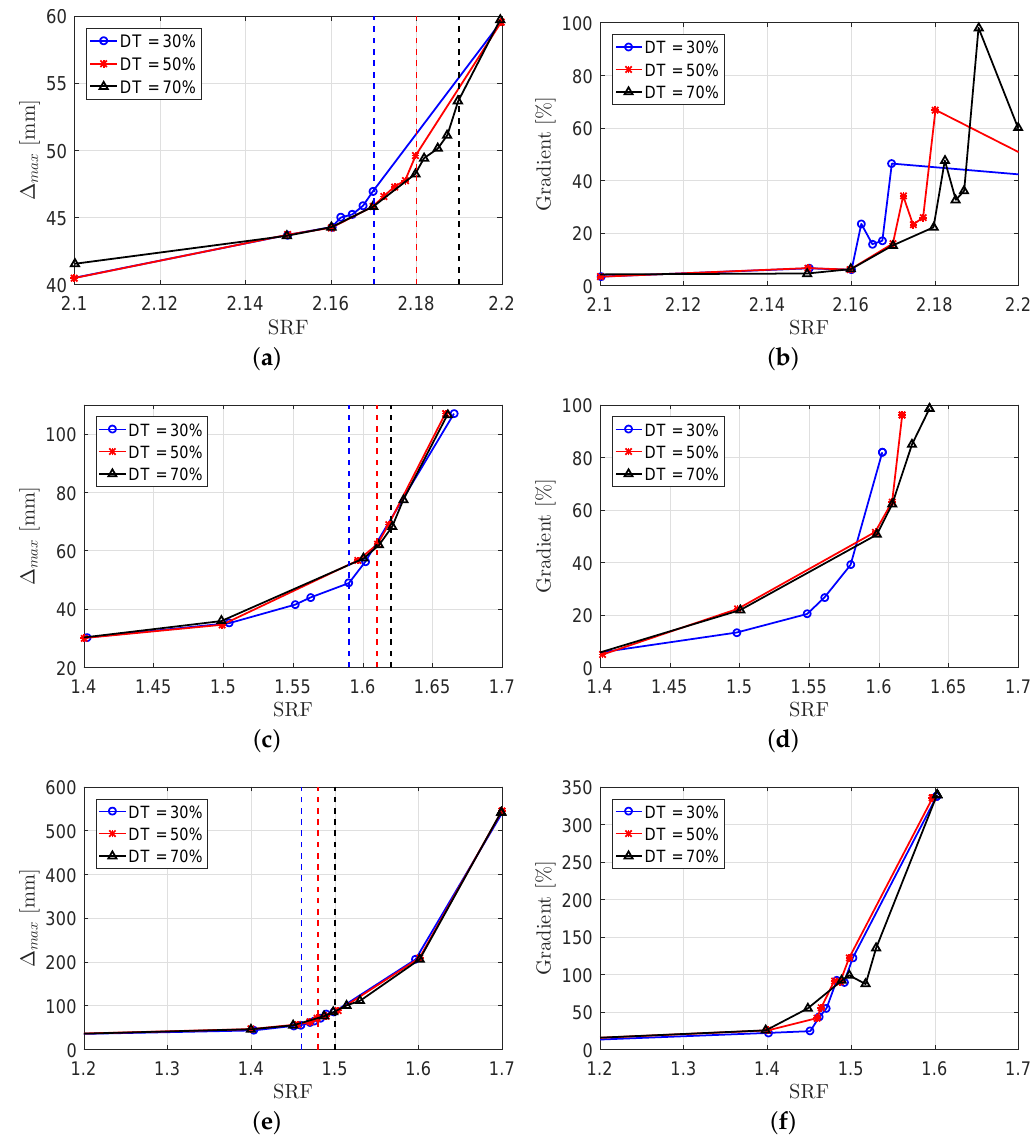
Figure 7. Determination of the SF based on the maximum displacement and relevant gradient diagrams. ( a ) Case 1, displacement, ( b ) Case 1, gradient, ( c ) Case 2, displacement, ( d ) Case 2, gradient, ( e ) Case 3, displacement, and ( f ) Case 3,